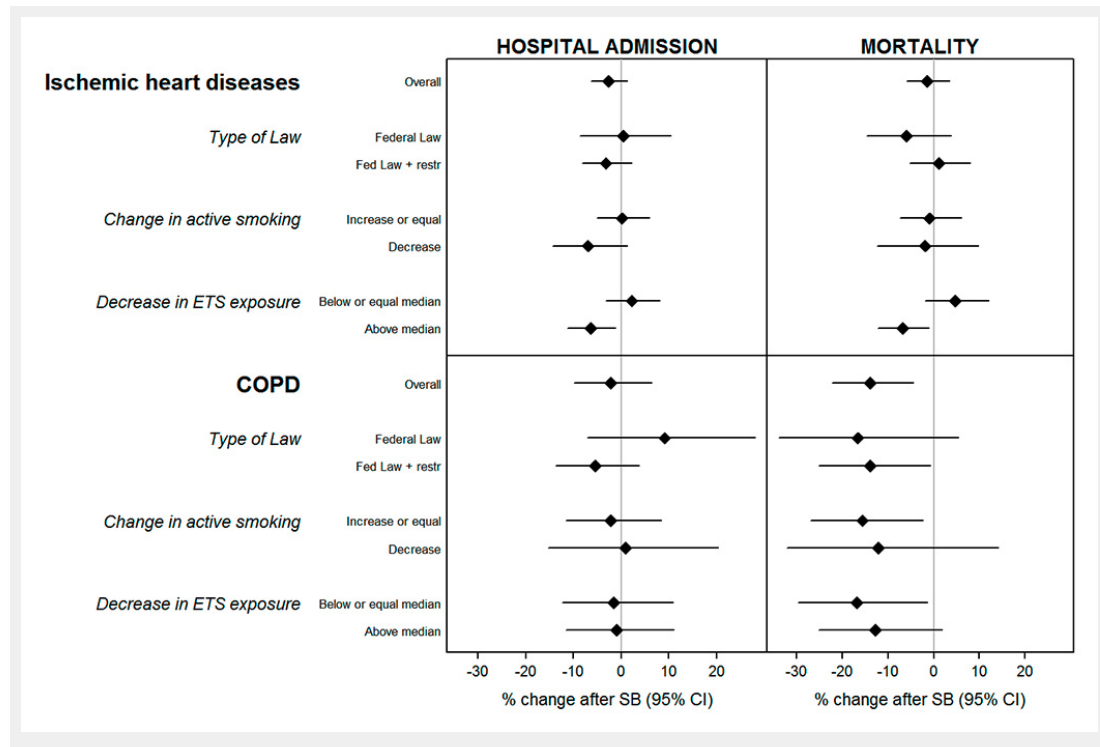
Figure 3 Change (and 95% confidence interval, CI) in hospital admissions and mortality due to ischaemic heart disease and chronic obstructive pulmonary disease (COPD) in adults (≥35 years old) after the introduction of the smoking ban, by type of law and smoking profile of the canton (adjusted for the socioeconomic and health profile of the population). SB = smoking ban. Type of law: Fed. Law = cantons which followed only the federal smoking ban, Fed. Law + restr = cantons which applied additional restrictions to the federal smoking ban. Change in active smoking: difference between the reported smoking prevalence in the Swiss Health Surveys of 2007 and 2012. Stratified by non-decrease vs decrease in prevalence. Decrease in environmental tobacco smoke (ETS) exposure: difference between the reported ETS exposure in the Swiss Health Surveys of 2007 and 2012. Since there was always a decrease, cantons were classified according to whether the decrease was above or below the median